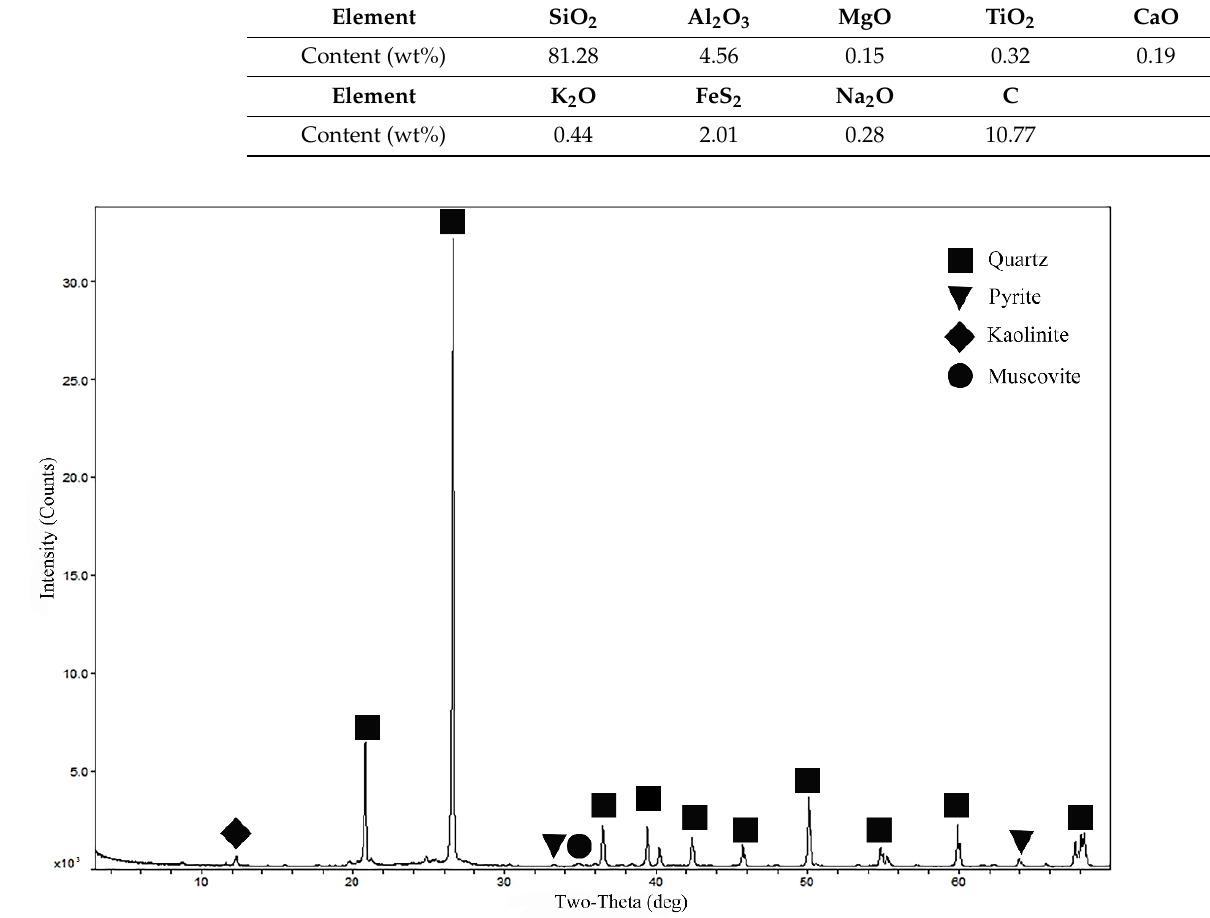
Figure 2. XRD spectra of the ore sample. Table 1. Multi-element analysis of the ore sample by ICP-MS and EA.